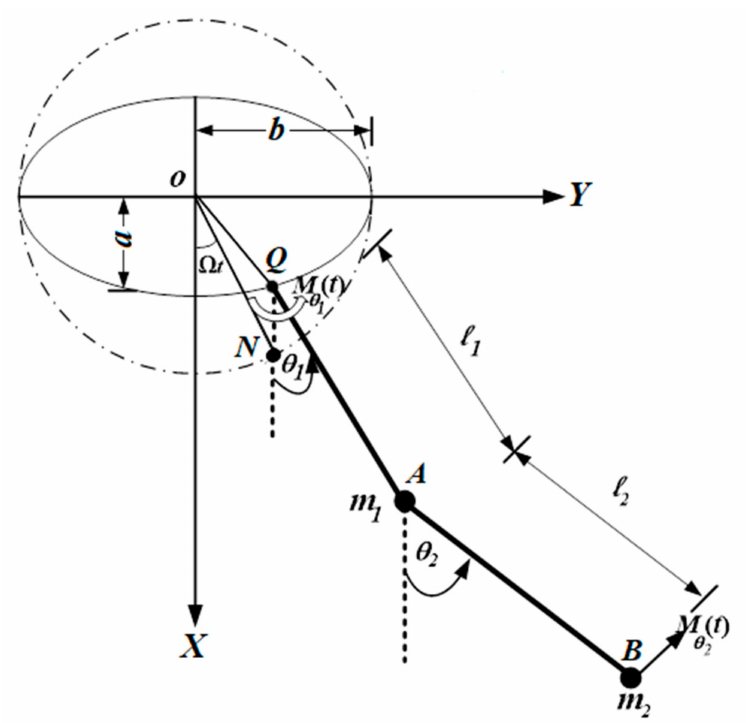
Figure 1. Description of the